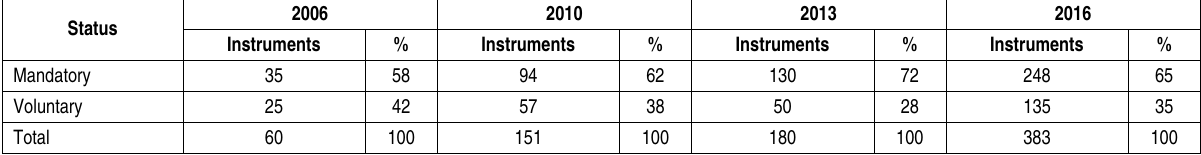
Table 2. The number of regulatory instruments used in the SR all over the world, period 2013-2016